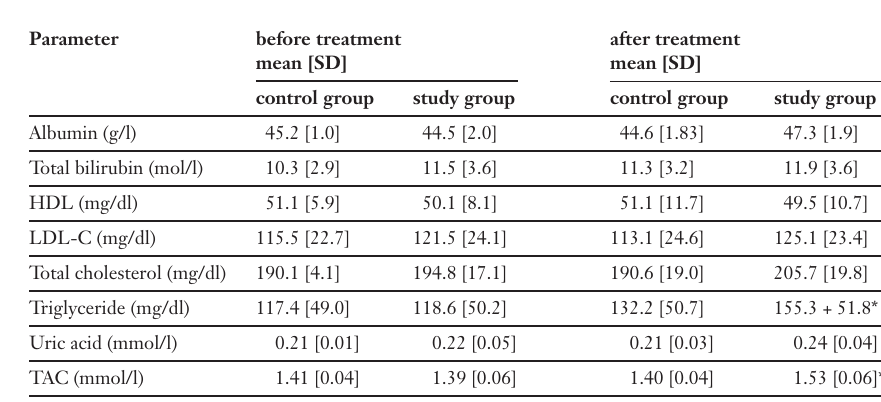
Initial subject charac- teristics and clinical data of the two groups of post- menopausal women. (Abbreviations; LH: Luteinizing hormone, FSH: Follicle stimu- lating hormone).